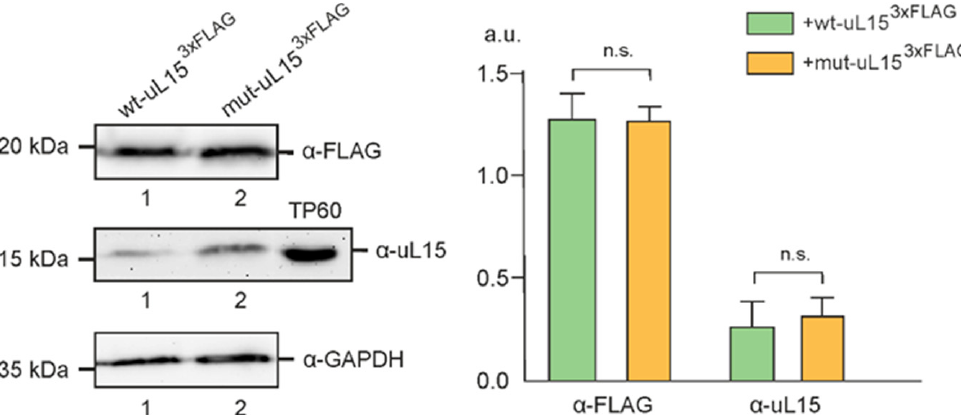
Figure 1. Production of exogenous 3 × FLAG-tagged wild-type ribosomal protein uL15 (wt-uL15 3 × FLAG ), and its mutated form with the H39A substitution (mut-uL15 3 × FLAG ) in HEK293T cells, transfected by corresponding constructs. On the left, Western blot analyses of exogenous 3 × FLAG-tagged proteins and endogenous uL15 and GAPDH as references in the cell lysates from wt-uL15 3 × FLAG -producing (1) and mut-uL15 3 × FLAG -producing (2) cells, using specific antibodies. Antibodies against natural uL15 did not react to exogenous forms of uL15, because of the 3 × FLAG-tag interference. TP60, the total protein of 60S ribosomal subunits used as a reference for the position of endogenous uL15. On the right, a diagram showing the densitometry analysis of the Western blot data from three biological replicates of the experiment in arbitrary units (a.u.) as the mean ± SEM. Note that there is no difference in the ratio of exogenous-to-endogenous uL15 signals between cells producing different FLAG-tagged proteins.